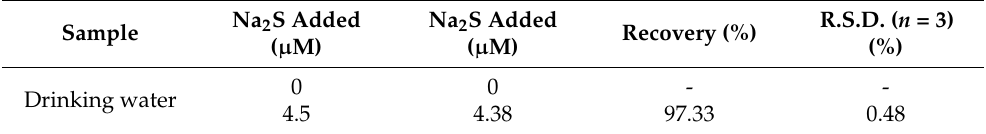
Table 2. Recovery-test results for S 2 − in the real-water sample